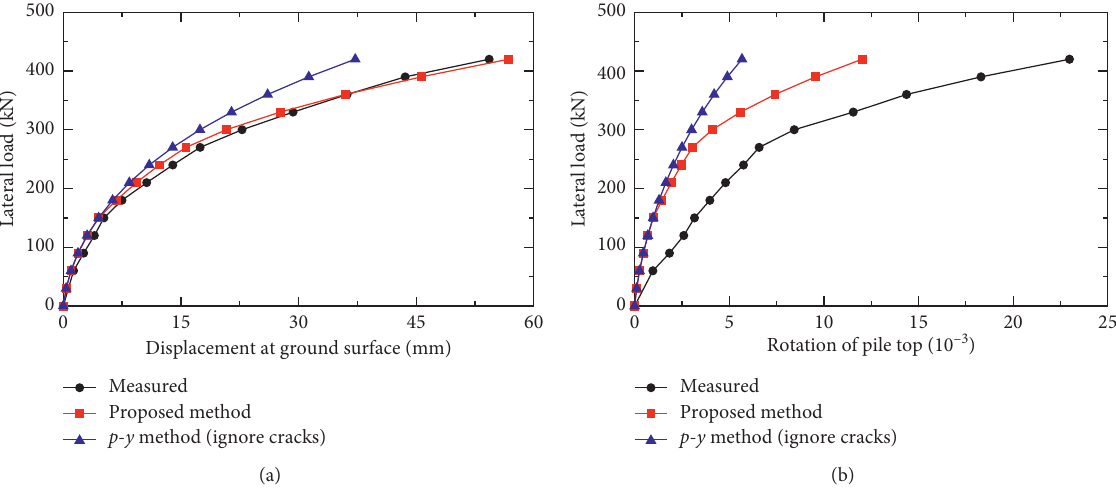
Figure 7: Comparison of calculated and measured results: (a) load-displacement curves; (b) load-rotation